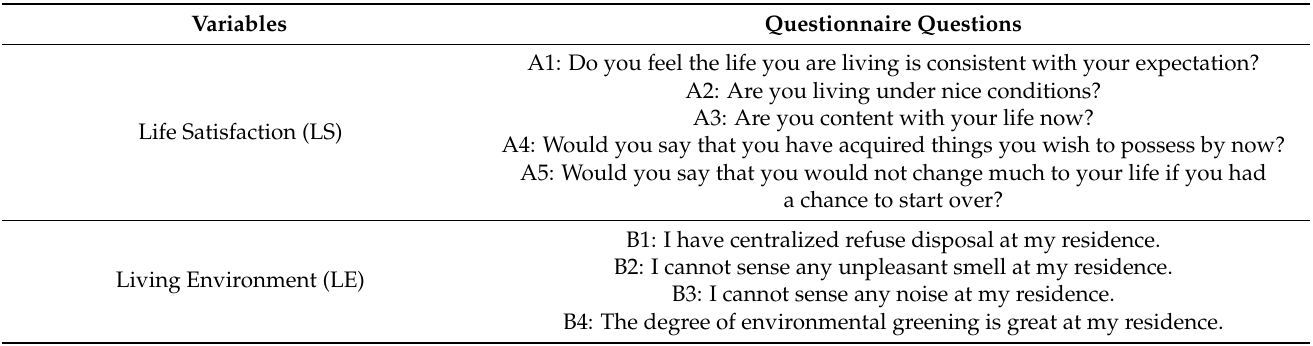
Table 1. Questionnaire